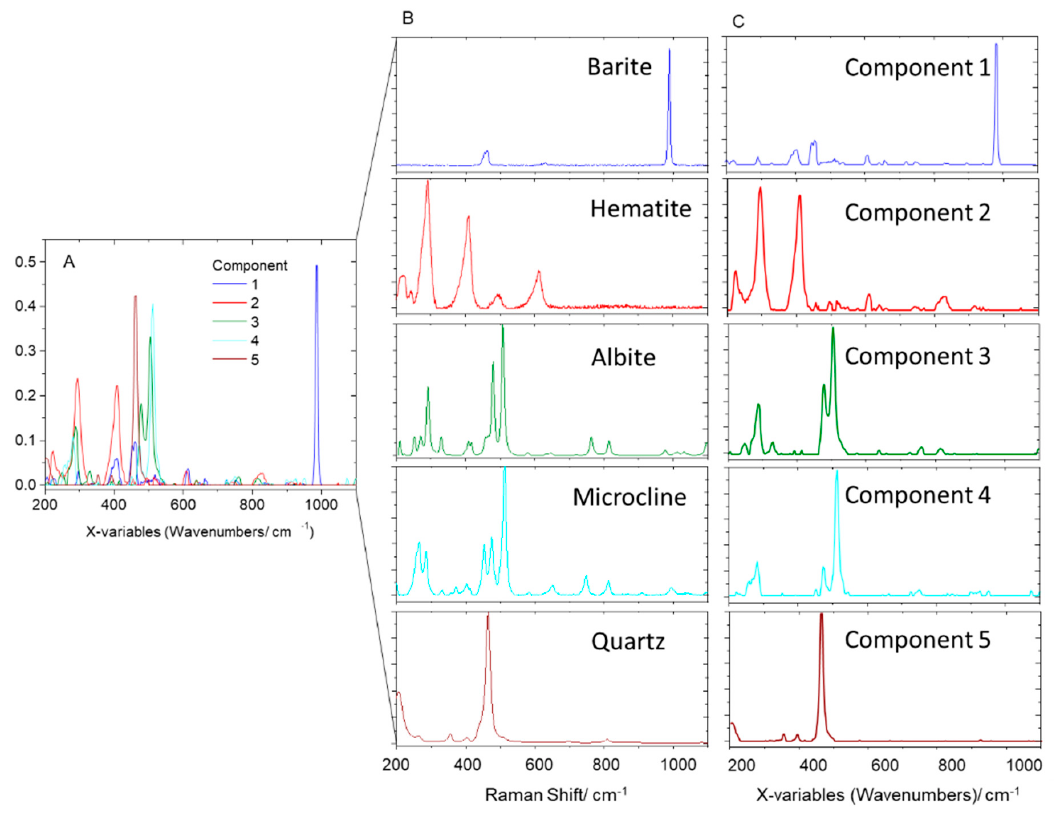
Figure 3. MCR components’ spectra ( A , C ) and Raman spectra of the identified minerals in the core section of the studied fulgurite ( B ). The components’ spectra were vector-normalized in A and normalized by the most intense peak in C; minerals’ spectra were normalized by the most intense peak. RRUFF reference spectra: barite, X050029.4; hematite, R060190; albite, X050005; microcline, R120005; quartz, R110108.